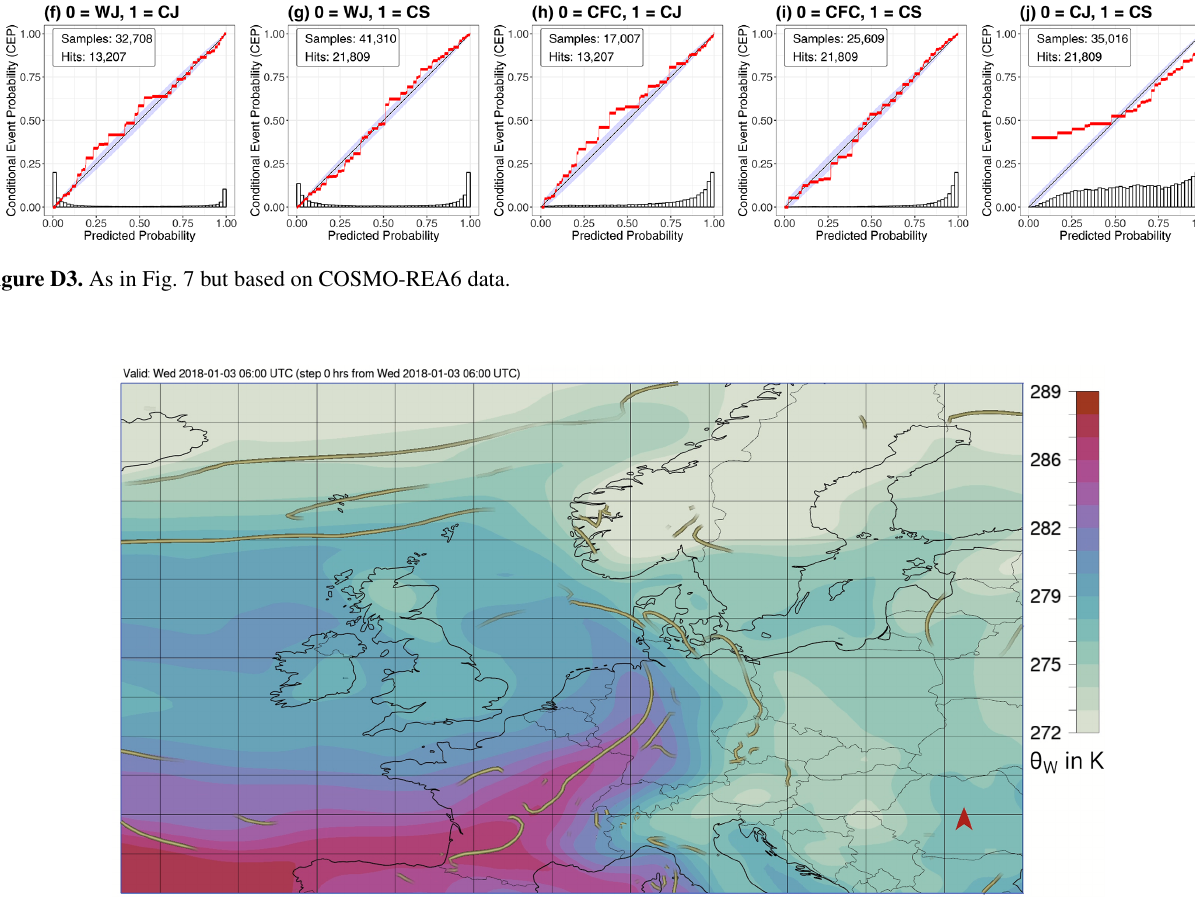
Weather Clim. Dynam., 3, 1157–1182, 2022